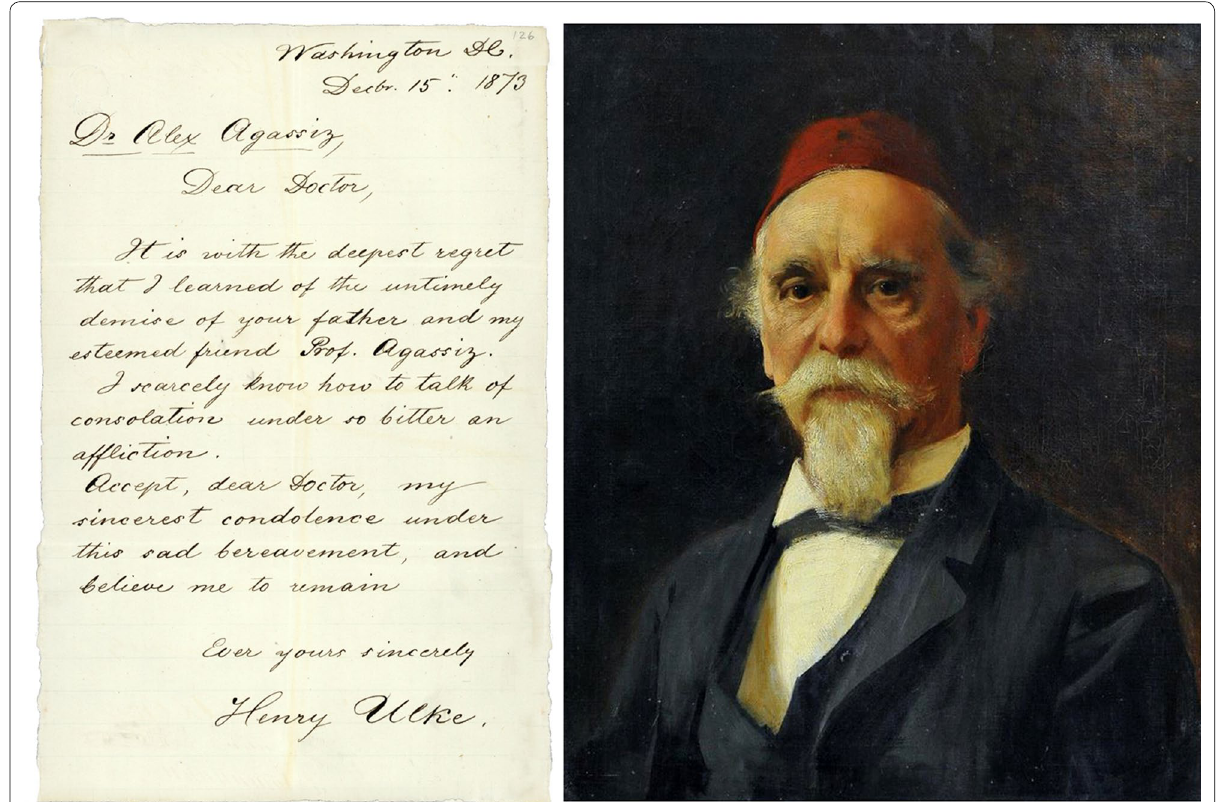
Fig. 4 Letter of condolence upon Louis Agassiz’s death, addressed to his son Alexander Agassiz, by Ulke (1873); and portrait depicting Henry Ulke at respectable age (oil on canvas), not signed, nor dated; courtesy of MCZ Archives, Ernst Mayr Library, Harvard University (bAg 15.30.3-126), and Auktionshaus David (sale of May 12, 2018, lot 76), respectively